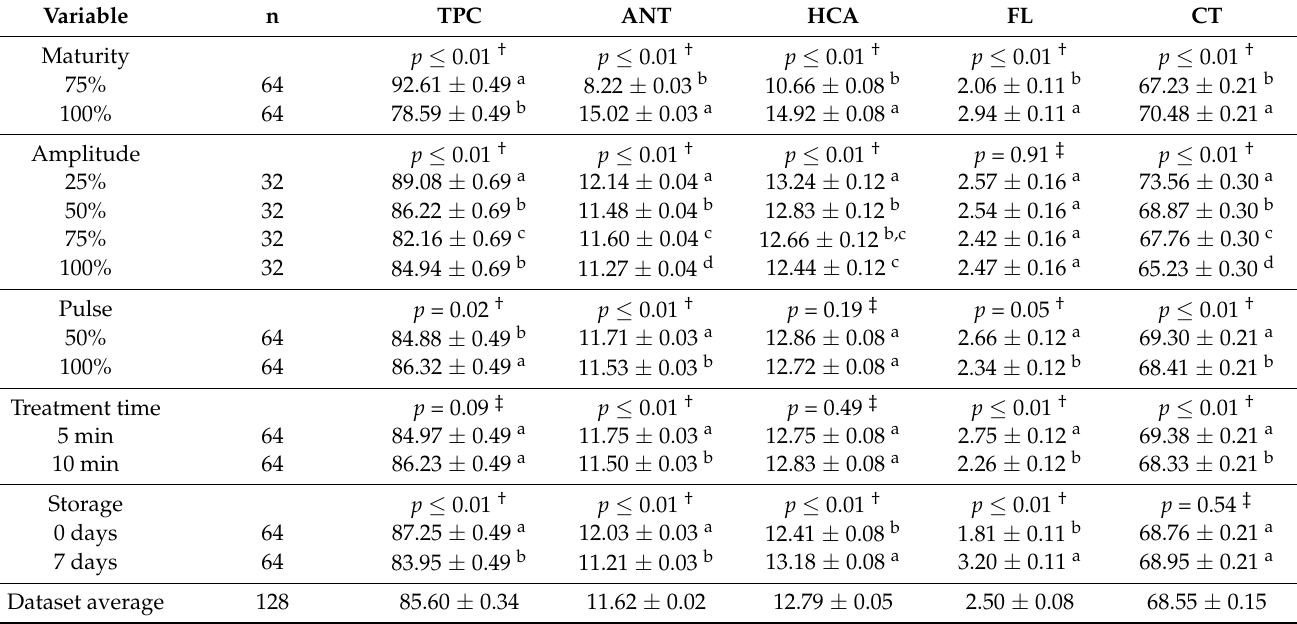
Table 4. Changes in the bioactive compounds in juice samples under HPU during